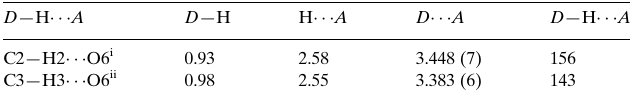
Hydrogen-bond geometry (A˚ , (cid:5)